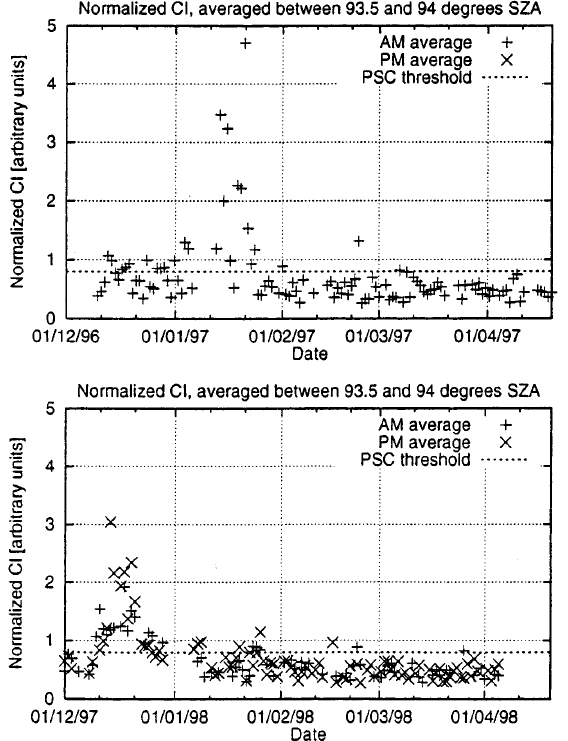
Fig. 4. Time series of colour index ratios [CI norm (cid:136) CI (cid:133) SZA (cid:134) = CI (cid:133) 90 (cid:14) (cid:134) ]